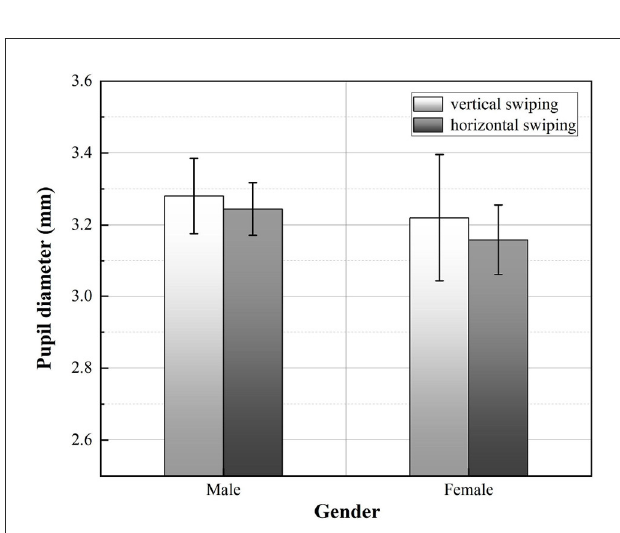
FIGURE12 Comparison of the pupil diameter averaged across participants. Error bars show the standard deviation